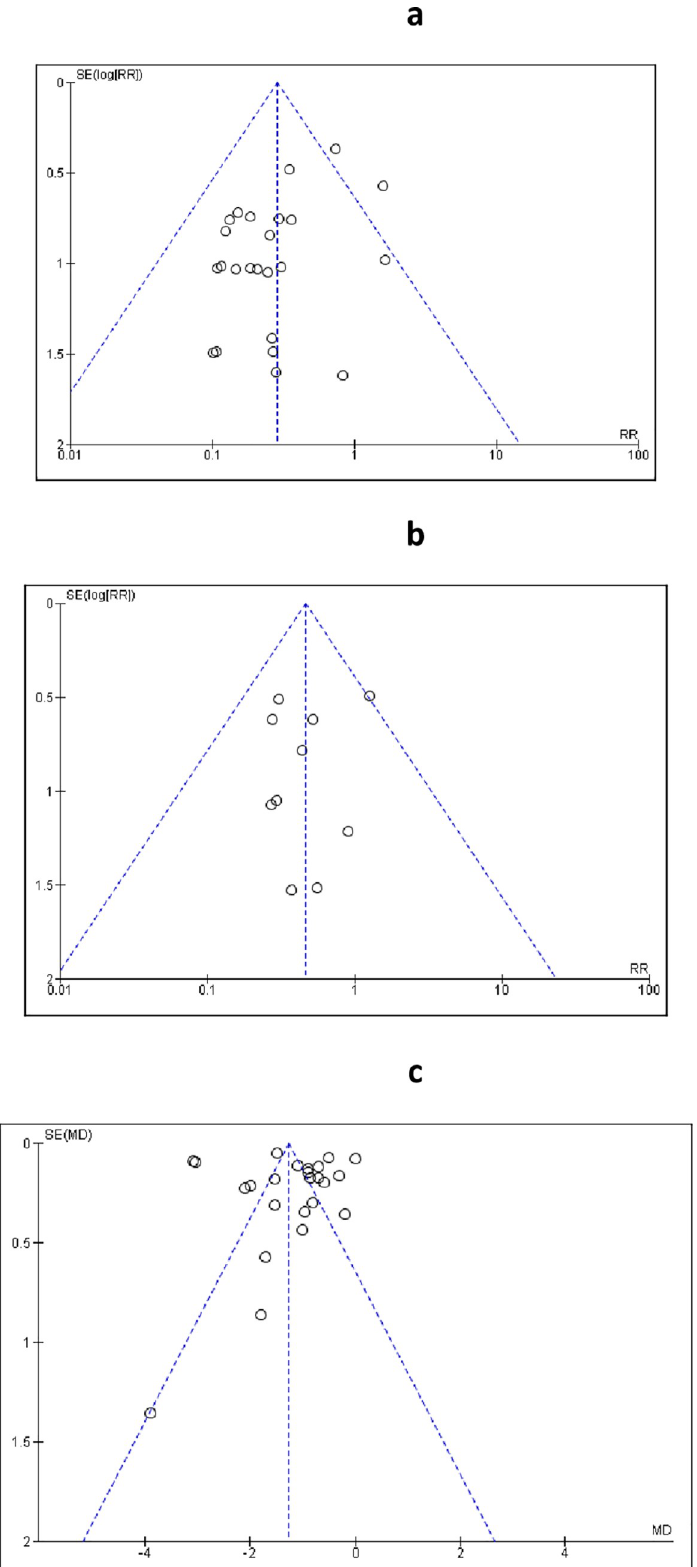
Fig 10. Funnel plots for studies included in the meta-analysis for the effect of PCC on congenital anomalies (a), perinatal mortality (b) and HbA1c (c). https://doi.org/10.1371/journal.pone.0237571.g010 PLOS ONE | https://doi.org/10.1371/journal.pone.0237571 August 18,